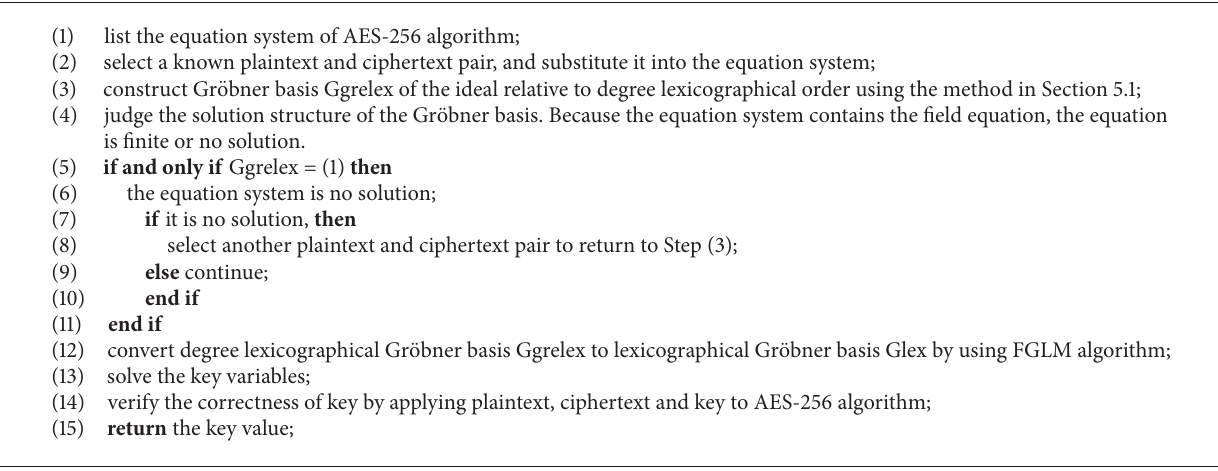
Algorithm 2: Algebraic cryptanalysis algorithm of